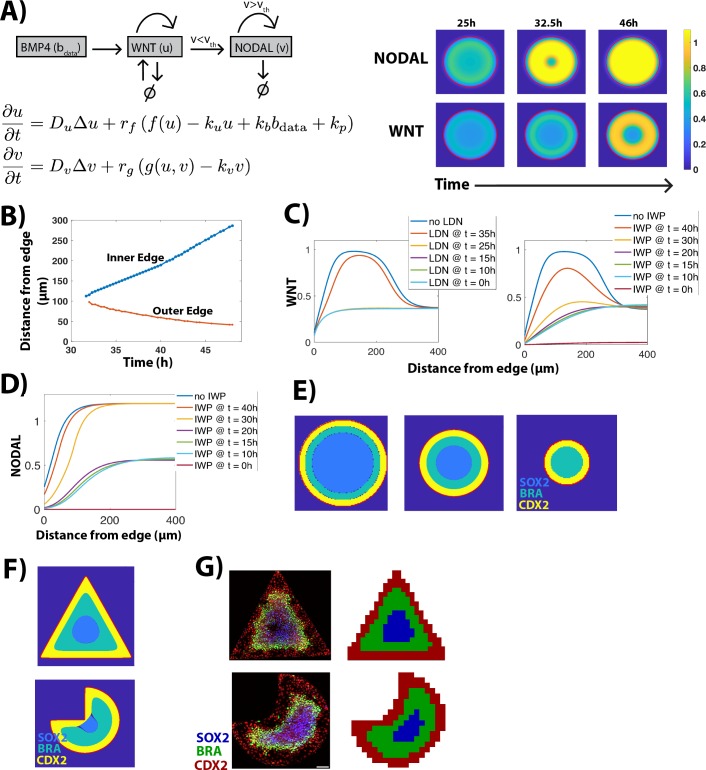
A simple mathematical model recapitulates signaling dynamics and predicts cell fate patterning.(A) (Left) Model equations. u and v represent WNT and NODAL signaling, respectively (parameter descriptions and values in S2 Model). (Right) Time evolution of WNT and NODAL to steady state. (B) The position of inner and outer edge of simulated WNT signaling levels as a function of time. (C) WNT levels at steady state (46 h) as a function of edge distance for different simulations. LDN addition was simulated by setting WNT’s dependence on BMP to 0 at indicated time points. IWP2 addition was simulated by setting autoactivation of WNT to 0 at indicated time points. (D) NODAL levels at steady state (46 h) for different simulations. (E, F) Fates assigned by the model on colonies of different sizes (E), shapes (F). (G) hESCs immunostained for CDX2, BRA, SOX2 after 44 h of BMP treatment on triangular and pacman colonies. Immunostaining data from n = 18 colonies were used to calculate average fate territory maps shown adjacent to image. Scale bar = 100 μm. Underlying data can be found in S10 Data. BMP, Bone Morphogenic Protein; BRA, BRACHYURY; hESC, human embryonic stem cell; LDN, LDN193189.